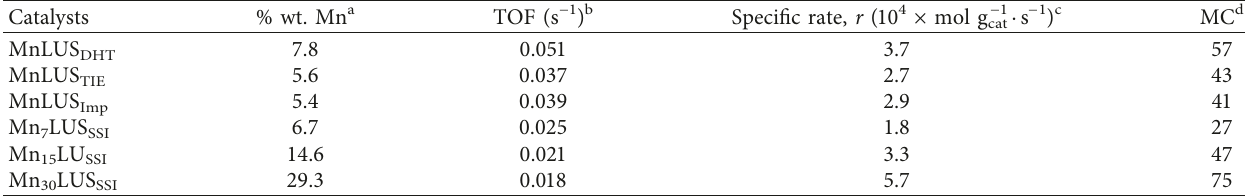
Table 2: Activity results for the catalytic oxidation of methane over the MnLUS